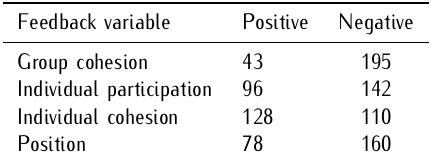
Table 9. Instance distribution in feedback variables.